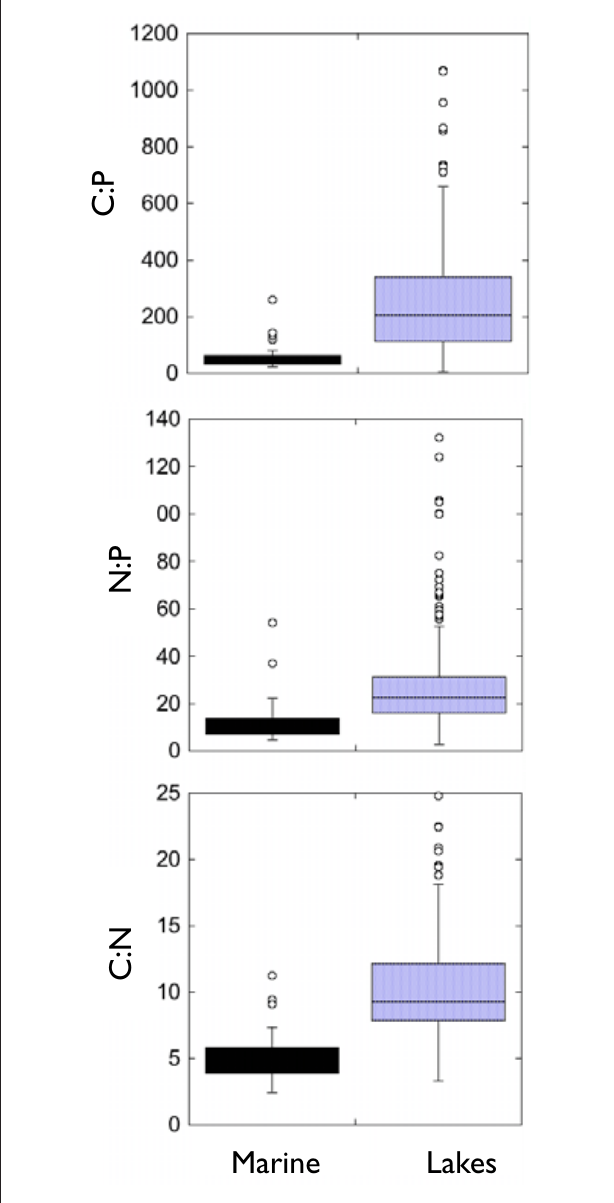
Figure 6 | Comparison of all marine measurements of microbial stoichiometry in a literature survey to the measurements from the present survey plus all other freshwater measurements of microbial stoichiometry in the literature. Literature used are presented in Table 3